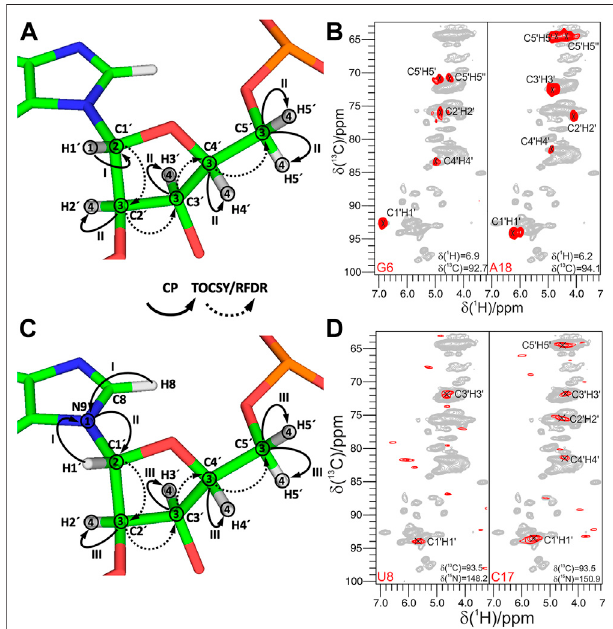
FIGURE 4 | Ribose assignment by 1 H-detected ssNMR. (A,C) Magnetization transfer for (A) 4D HCCH-TOCSY and (C) 4D (H)NCCH- TOCSY experiments. Solid arrows indicate CP transfers and dotted arrows indicate homonuclear 13 C, 13 C TOCSY/RFDR recoupling; Arabic numbers indicate spectral dimensions (t 1 – t 4 ); Roman numbers indicate CP transfers. Assignment of ribose spin systems with (B) 4D HCCH-TOCSY and (D) 4D (H)NCCH-TOCSY experiments. In (B) representative 2D planes from the 4D experiment show the spin systems of G6 and A18. 1 H and 13 C frequencies are indicated in each panel. In (D) representative 2D planes from the 4D experiment show the spin systems of U8 and C17. 13 C and 15 N frequencies are indicated in each panel. For reference, the red contours of either HCCH-TOCSY or 4D (H)NCCH-TOCSY spectra are overlaid onto 2D CP-HSQC spectra (in gray). The HCCH-TOCSY spectrum was recorded on an 800 MHz spectrometer at a MAS frequency of 100 kHz, while the (H) NCCH-TOCSY spectrum was recorded on a 1 GHz spectrometer and at 100 kHz MAS. Figures (B) and (D) are reproduced from (Marchanka et al., 2018b) with permission from the Royal Society of